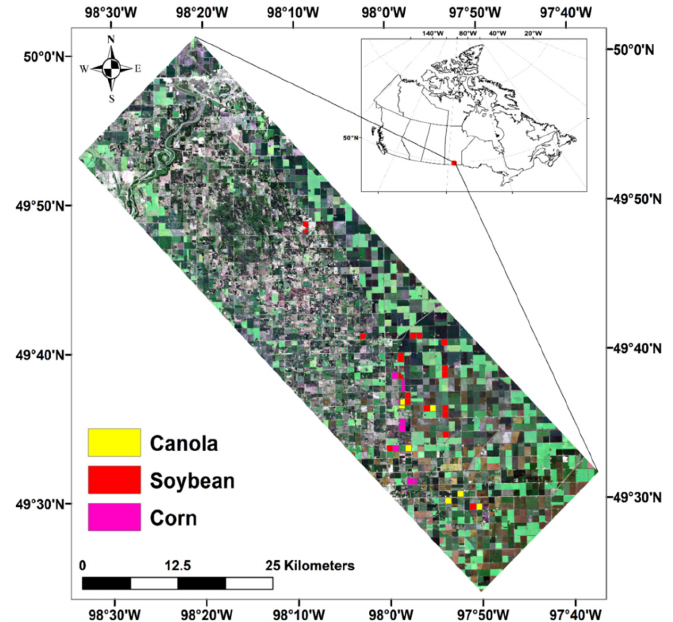
Figure 1. Location of study area ding SMAPVEX-12 campaign, the identified fields have been used in this research.